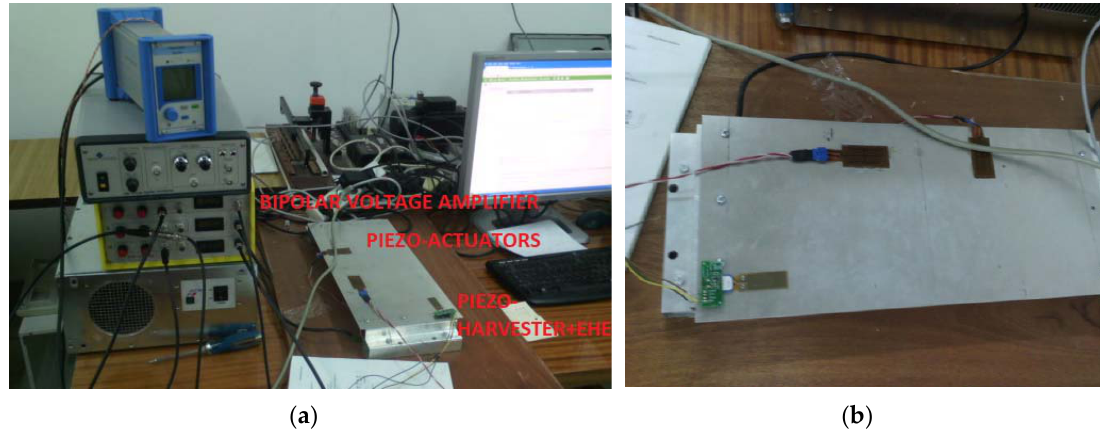
Figure 9. ( a ) The laboratory stand, ( b ) the smart plate with piezo-elements (actuators QP10N and harvester V21BL) located on its top surface.